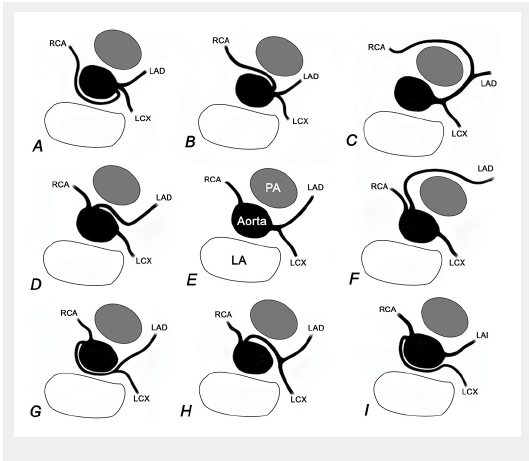
Schematic illustration of a selection of coronary artery anomalies. For comparison, the normal anatomical situs is given in the middle (i.e., Panel E). A: ACAOS with RCA originating from the LCS with a retroaortic course. B: ACAOS with RCA originating from the